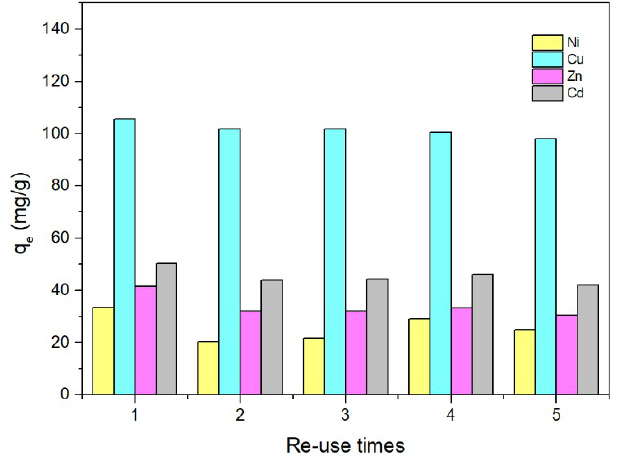
Figure 10. Effect of recycling on Cu(II), Zn(II), Ni(II) and Cd(II) ion adsorption. Reaction conditions: = 293 K, [Zn(II)] = [Ni(II)] = [Cd(II)] = 200 mg / L; reaction time = 12 T = 293 K, [Zn(II)] 0 = [Ni(II)] 0 = [Cd(II)] 0 = 200 mg/L; reaction time = 12 h. 0 0 0